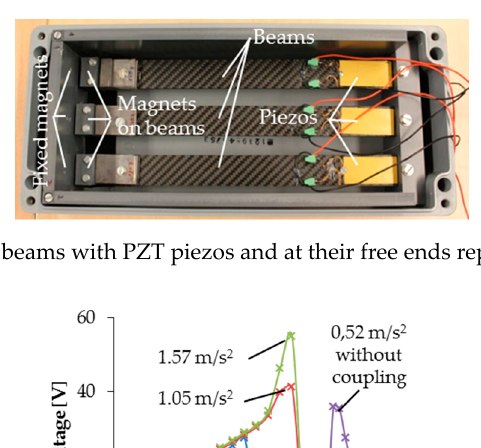
Figure 6. PZT stripes on a beam with repellent magnet at its free end (not to scale).